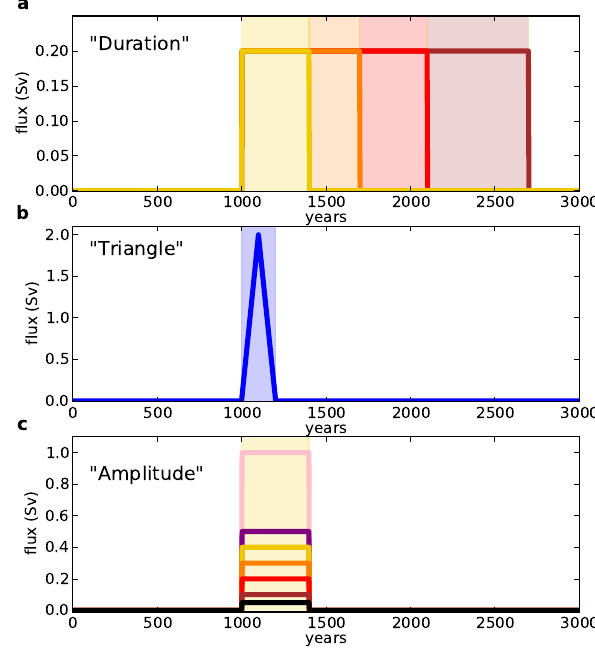
Fig. 1. Evolution of the fresh water flux (Sv) in the three types of experiments: (a) for the “Duration” experiments with fresh water fluxes of 0.2Sv added during 400, 700, 1100 or 1700 yr, (b) for the “Triangle” experiments with a fresh water flux linearly increasing for 100yr to 2Sv, then decreasing again from 100 yr, and (c) for the “Amplitude” experiments with fresh water flux added during 400 yr of 0.05, 0.1, 0.2, 0.3, 0.4, 0.5 or